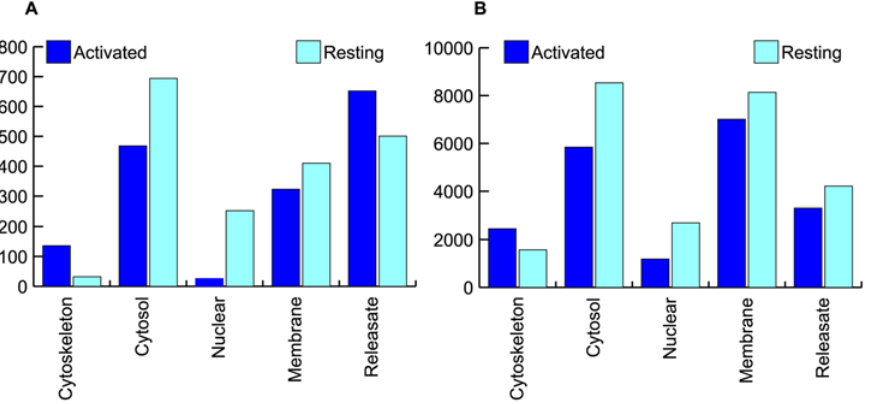
Figure 3. Characteristics of the exon skip events detected in human platelets. (A) and (B) describe the distribution of the SkipE and IPI peptides respectively, across the different subcellular compartments for both resting and activated platelet samples.